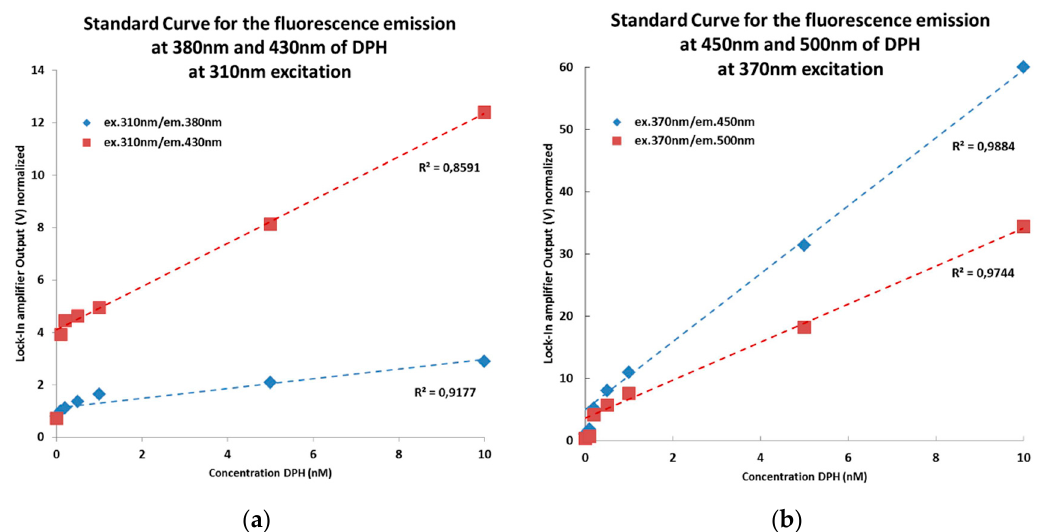
Figure 3. ( a ) Standard Curve of the sensor system with DPH in cyclohexane for the fluorescence emission at 380 nm and 430 nm at 310 nm excitation (BIX analysis). ( b ) Standard Curve of the sensor system with DPH solved in cyclohexane for the fluorescence emission at 450 nm and 500 nm at 370 nm excitation (FIX